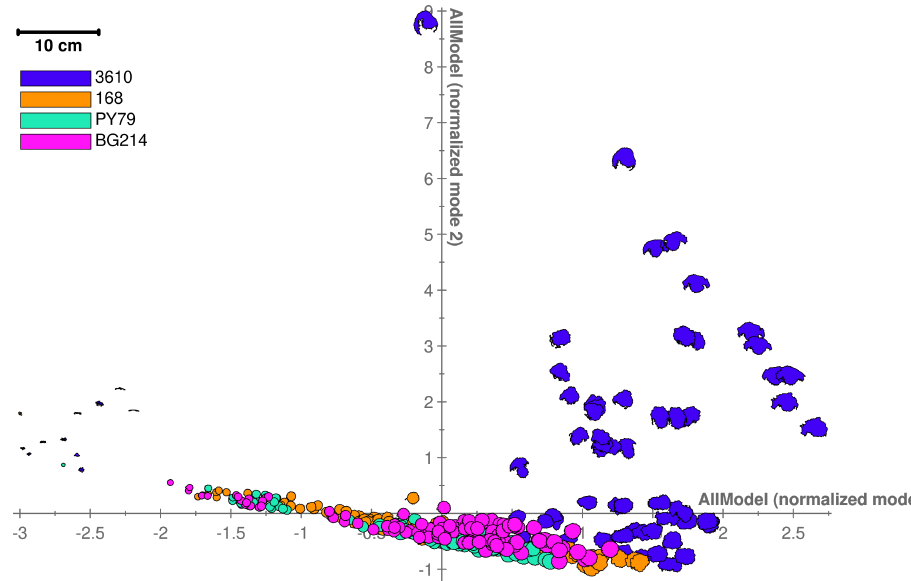
Figure 5. Distribution of shape contours including noise (smaller cell assemblies and artifacts) shows that distinct curvatures can be identified along the distinct phenotypes. W3610 (blue) shows the most heterogeneous and strong curved shape followed by 168 (orange). Both swarmer phenotypes are clearly distinct compared to the less motile strains PY79 (green) and BG214 (magenta). Remarkably, W3610 localizations are less centered compared to the other strains, especially PY79, which indicates the ability to swarm and conquer the surrounding media faster and can be relocated to specific localization patterns as shown here using principal components based on the area and curvature. Keeping in mind that the dataset consists of a repeatedly acquired and temporarily pooled set of gray- scale images, it is powerful enough to monitor the underlying heterogeneity of variances between the isolated contours of the respective phenotypes. Figure created using Inkscape 0.92.3, available at: https://www.inkscape.org (accessed on 15 September 2022) and celltool